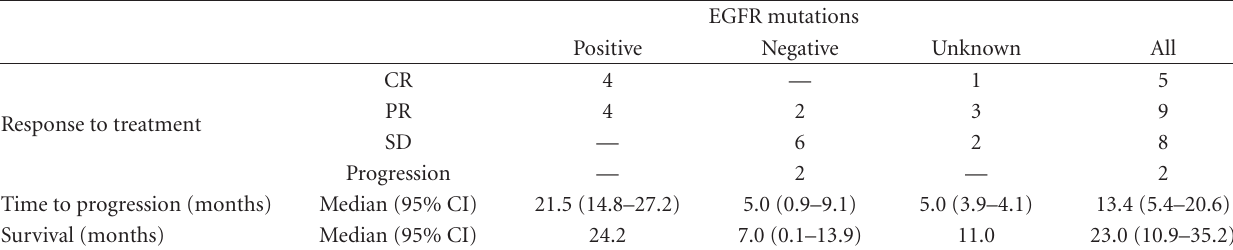
Table 2: Response to treatment, time to progression, and survival in relation to EGFR